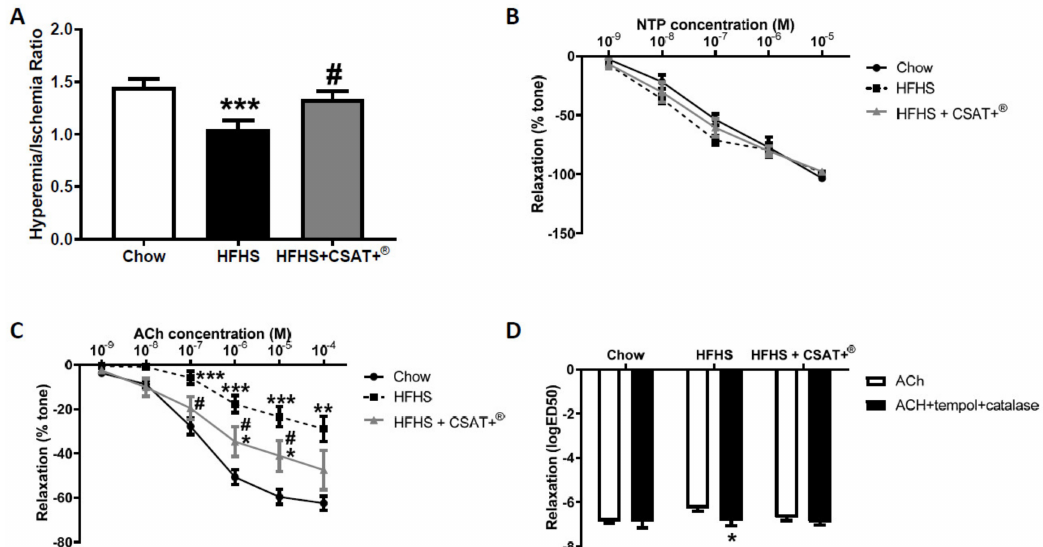
Figure 5. Reactive hyperemia ( A ),relaxation of thoracic aortic rings to sodium nitroprusside ( B ) and acetylcholine alone ( C ) or in the in the presence / absence of tempol + catalase ( D ) of mice fed a standard diet (Chow), a high fat diet / sucrose diet (HFHS), or high fat diet / sucrose diet supplemented with the carob pod extract (HFHS + CSAT + ® ). * p < 0.05; ** p < 0.01 vs. chow; *** p < 0.001 vs. chow. # p <